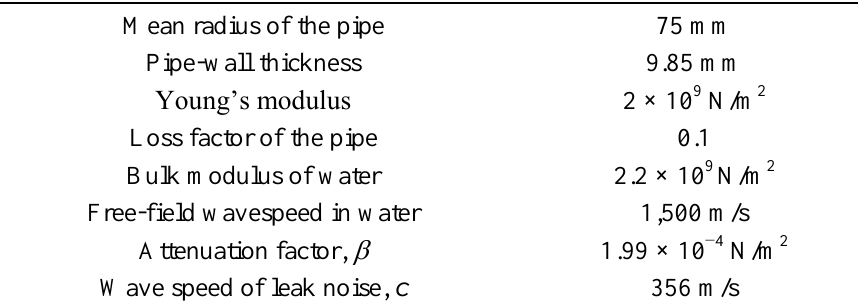
Figure 2.     max S S   for different type of sensors. Solid blue line, hydrophone; x x x x 1 2 1 2 dashed green line, geophone; dotted-dashed red line, accelerometer.   S  within the frequency range greater than or equal to 10 maximum value of   1 2 x x